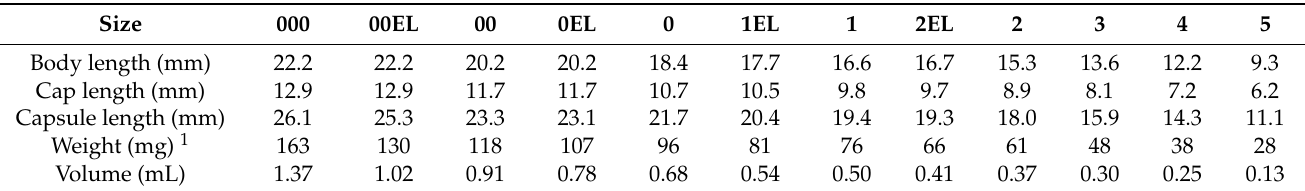
Table 3. Sizes, volumes, weights, dimensions of capsule parts (body, cap), and the whole capsule [48–50].